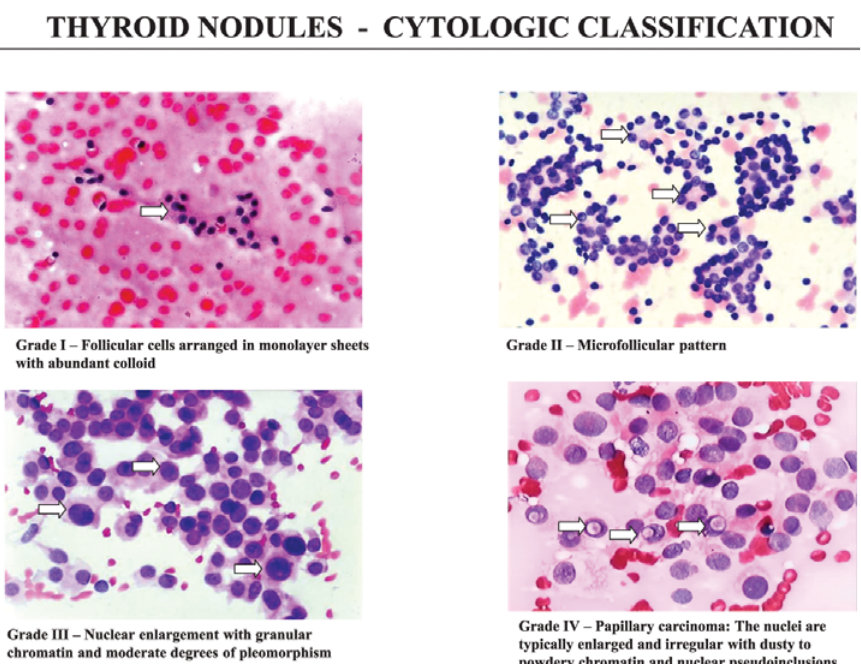
Figure 2 - Cytological classification of aspirates of thyroid nodules. From top left, clockwise: grade I, follicular cells with dense and homogeneous chromatin and abundant colloid; grade II, microfollicular pattern with nuclei with homogenous chromatin and scanty colloid; grade III, suspicious pattern with nuclear enlargement, prominent nucleoli, granular chromatin and absent colloid; and grade IV, malignant pattern represented by papillary carcinoma with enlarged and irregular nuclei, powdery chromatin and pseudoinclusions. The FNAB was indeterminate. Note the intense FDG uptake with a SUV max. of 8.8. The histopathological diagnosis was a well differentiated, minimally invasive follicular cancer. Another lesion was found in the right lobe (papillary microcarcinoma of 4 mm is not identified in the FDG-PET 16